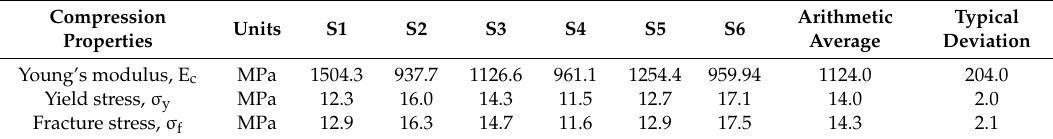
Table 9. Elastic and mechanical properties of PETG for each Y-axis